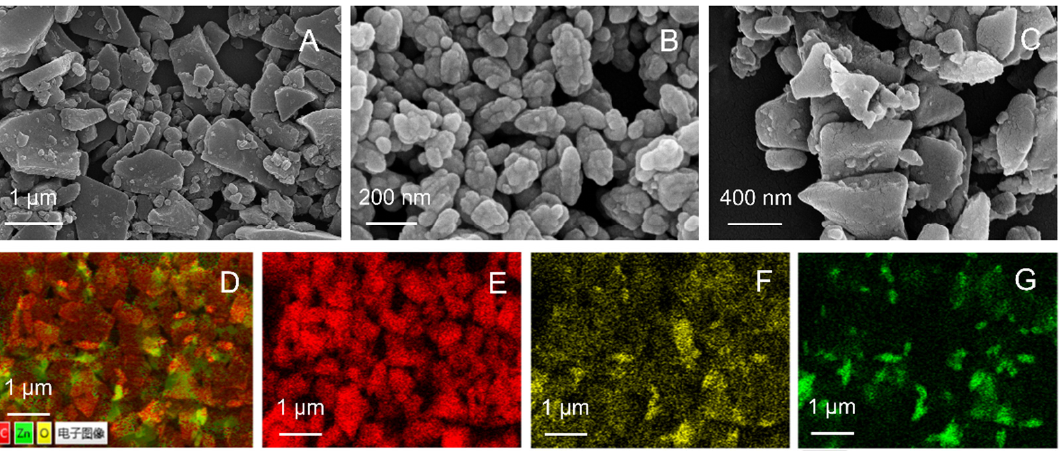
Figure 1. SEM images of ( A ) BC, ( B ) ZnO, ( C ) ZnO/BC. EDS layered image of ( D ) ZnO/BC (The electronic image). EDS mapping of ( E ) C, ( F ) O, and ( G ) Zn elements.